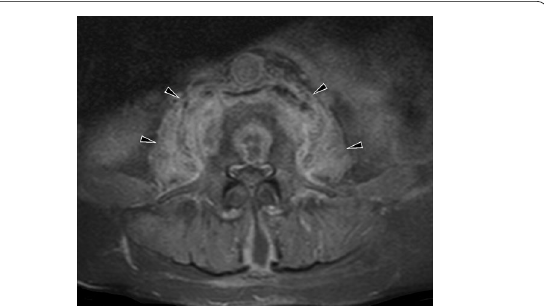
Fig. 44 Contrast-enhanced T1 weighted axial MR image of a 52-year-old male appears an inflammatory mass lesion within the adjacent soft tissues to the body of the fourth lumbar vertebra be caused by a phlegmon and abscess